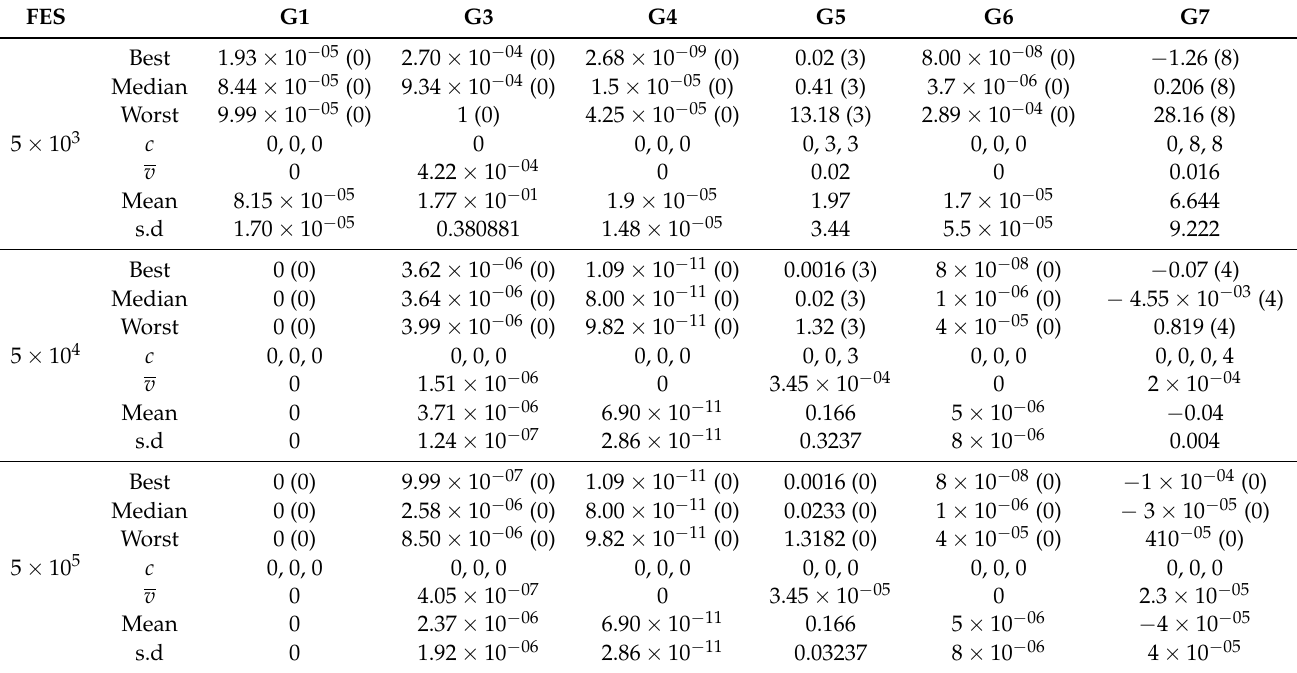
Table 2. Error values achieved if FES = 5 × 10 3 , FES = 5 × 10 4 , FES = 5 × 10 5 for G1, G3, G4, G5, G6 and